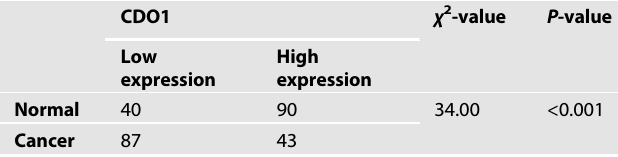
Table 1. Statistic analysis of CDO1 expression in GC/normal